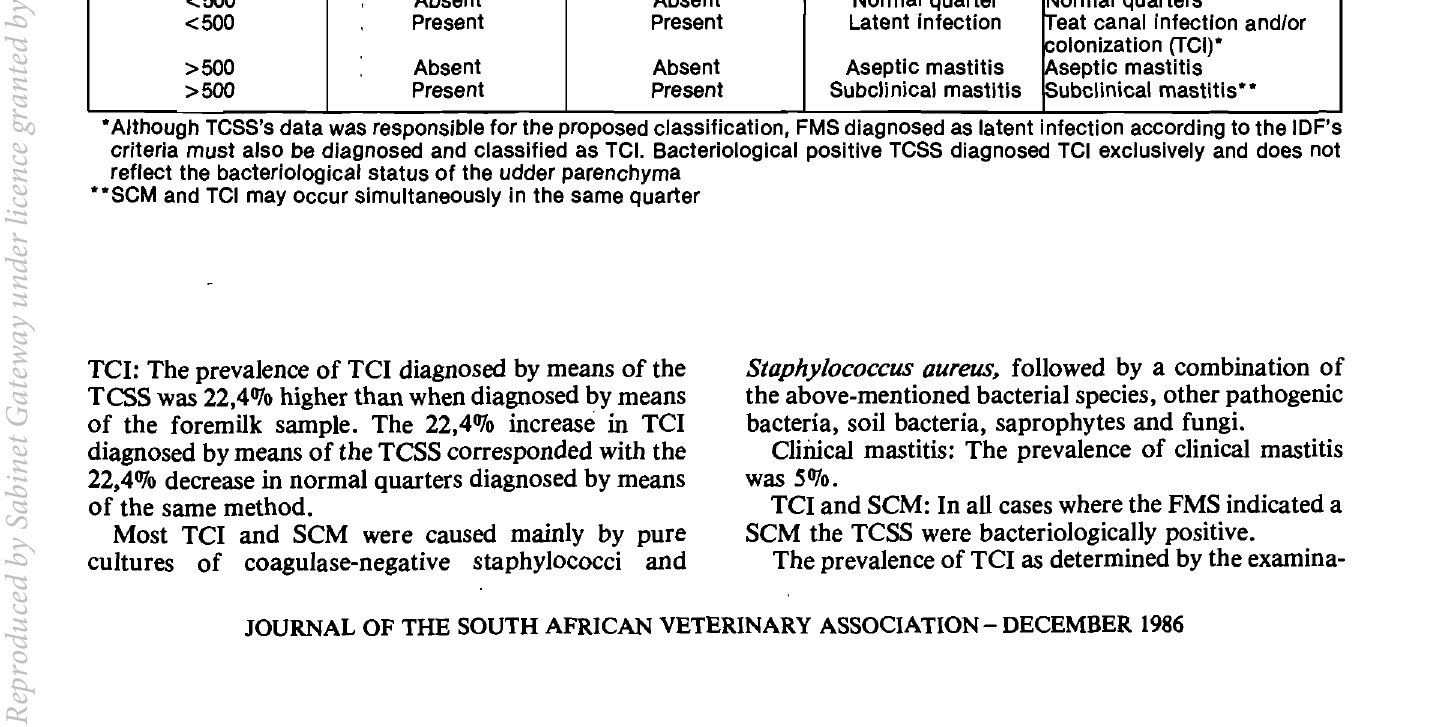
Table 3. Existing International Dairy Federation's (IDF) and newly proposed classification of health status of quarters for subclinical bovine udder infection/inflammation as determined by the somatic cell count of the foremilk sample (FMS) and the bacteriology of the teat canal swab sample